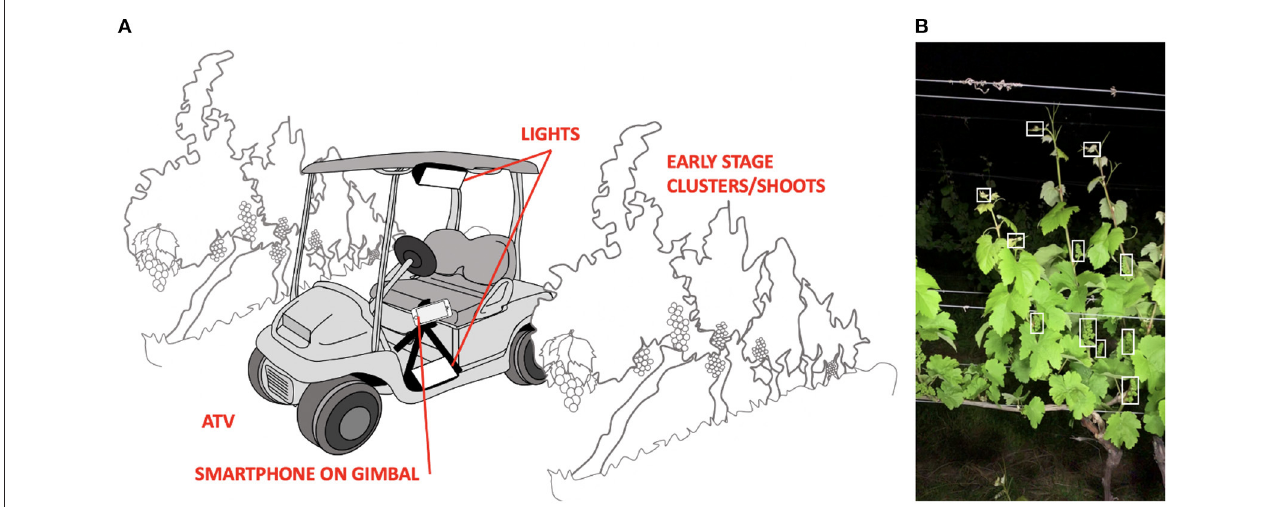
FIGURE 1 | (A) Diagrammatic representation of setup to perform automated cluster and shoot counts in vineyards. (B) Frame from the recorded video, with example clusters highlighted in the white box.